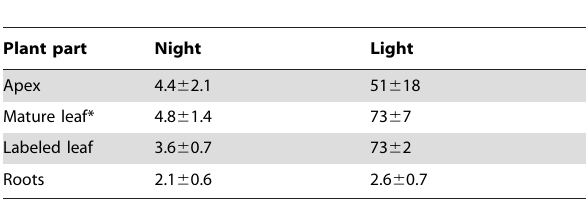
Table 1. Contribution of C loss (%) as isoprene in different plant’s parts relative to total C loss as BVOC during night and light emissions in experiments with intact